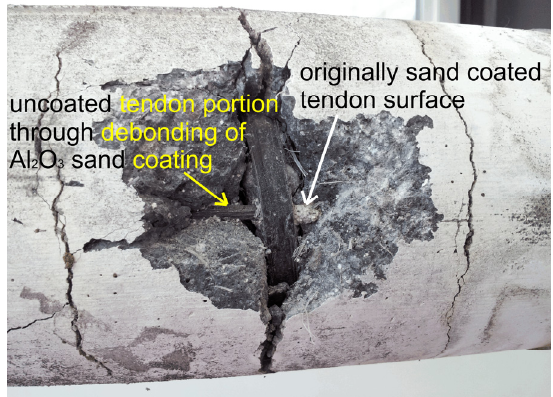
Figure 7. Detail of the tensile edge of the failed cross-section of pole No.14 after removing the HPSC